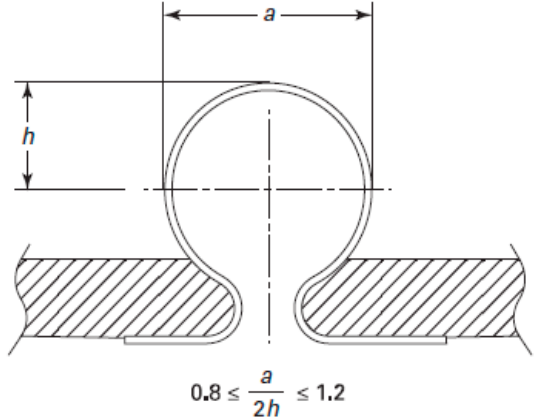
Figure 15. Permissible tolerances for bellows manufacture (mm) [17]. Factors affecting the forming quality include pressure (P 1 ) at the bulge stage, pressure(P 2 ) at the fold stage, middle radius of small arc (r0), middle radius of big arc (r), middle diameter of tube blank (D), opening size of toroid (L0), wave height (H) and wall thickness (t). Dimensions of bellows are shown in Figure 16.